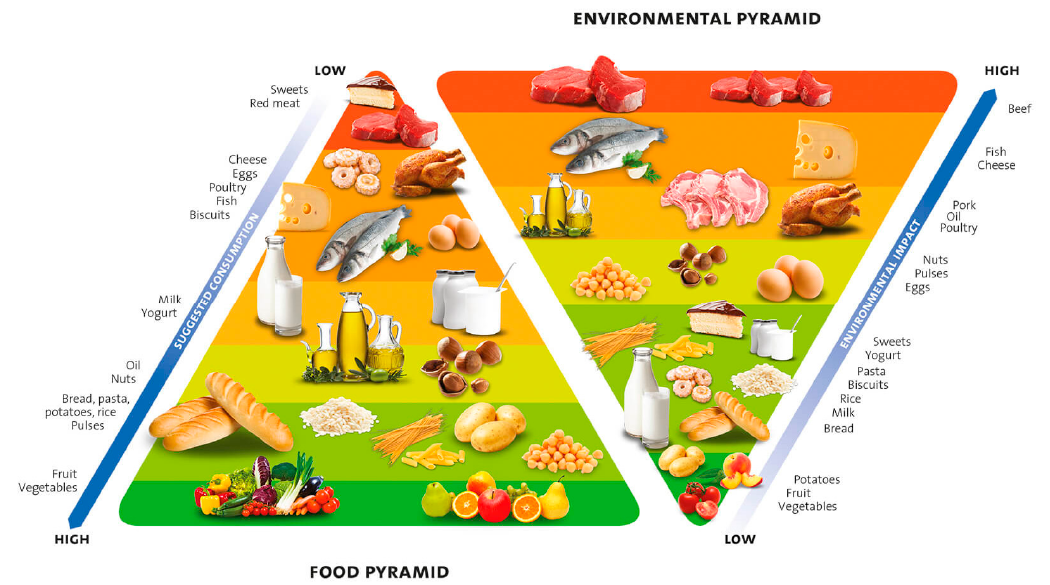
Figure 1. The double food and environmental pyramid model. Source: https://www.barillacfn.com/en/dissemination/double_pyramid/.